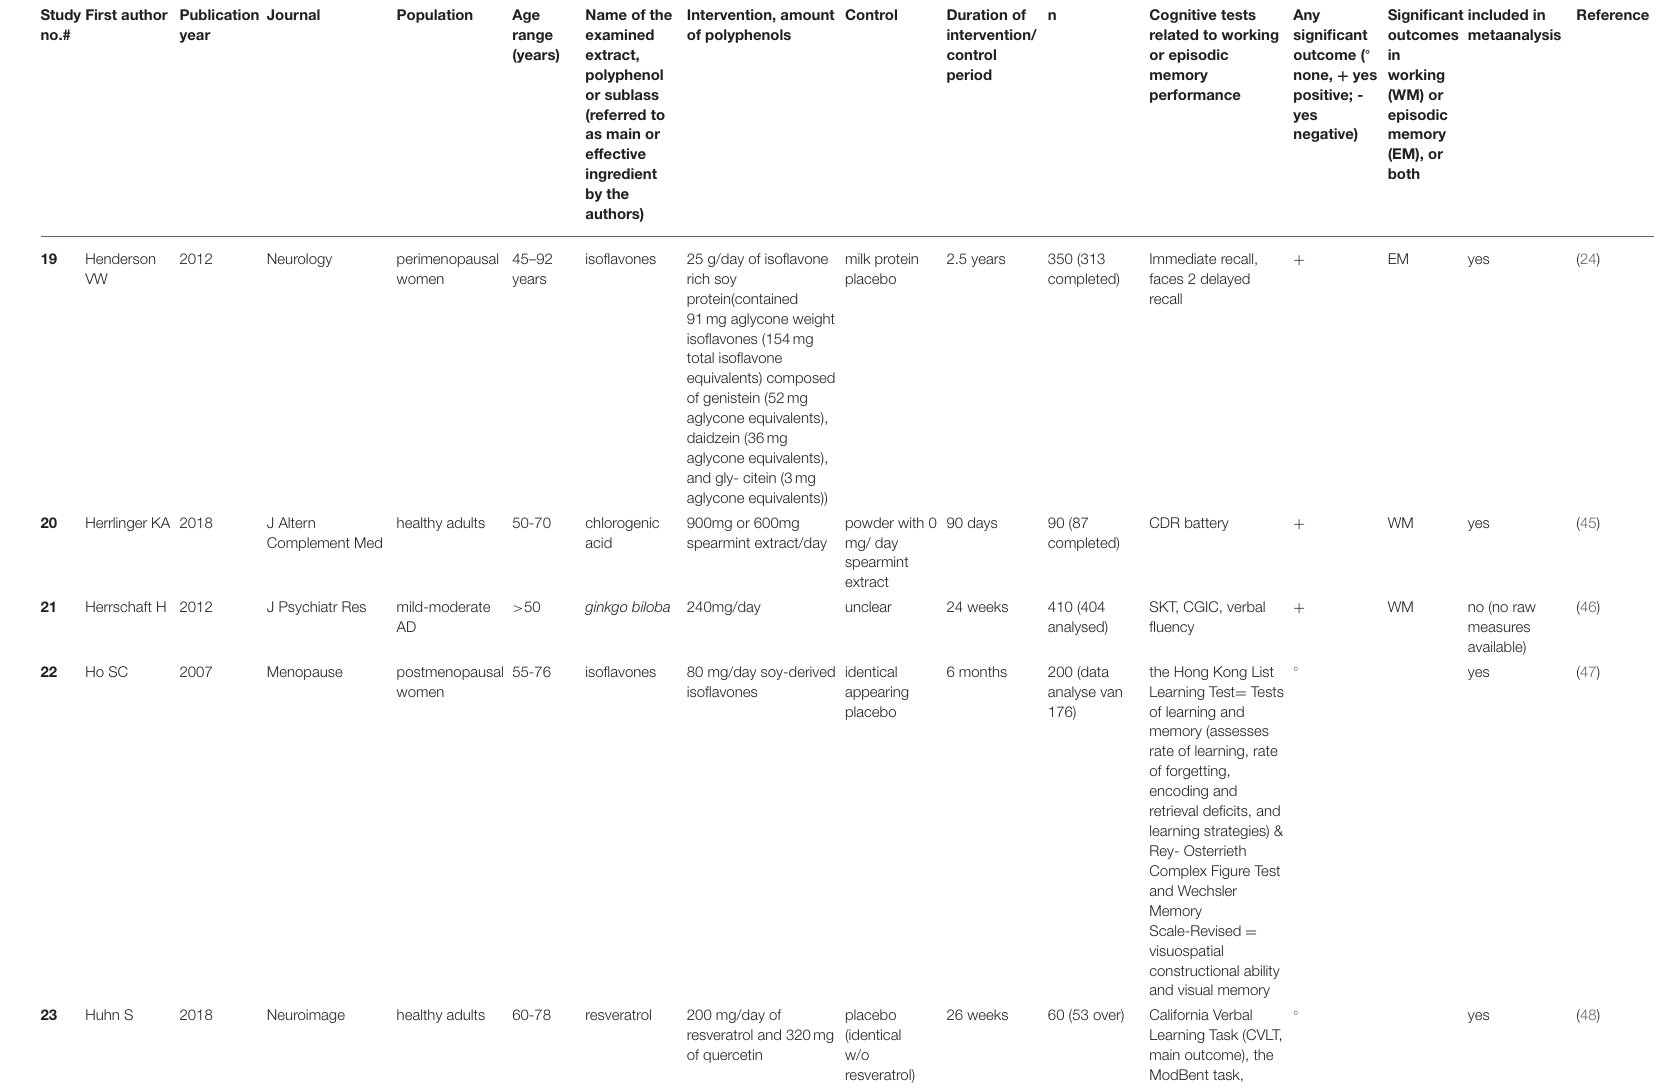
the Hong Kong List Learning Test = Tests of learning and memory (assesses rate of learning, rate of forgetting, encoding and retrieval deficits, and learning strategies) & Rey- Osterrieth Complex Figure Test and Wechsler Memory Scale-Revised = visuospatial constructional ability and visual